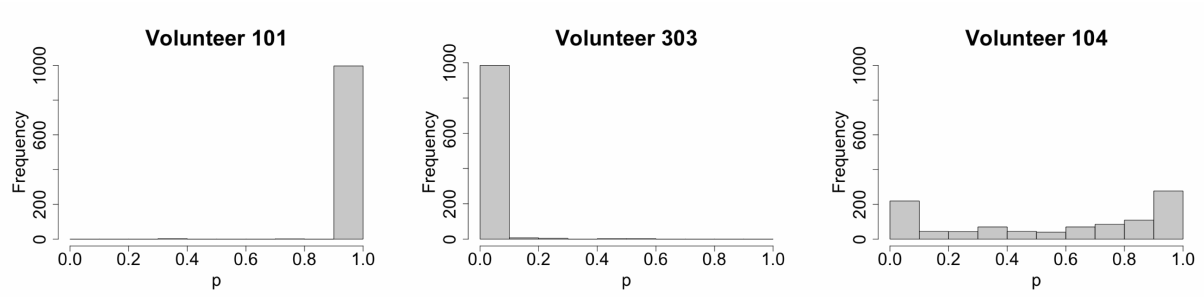
Figure 5. Distribution of the extinction probability at the end of simulation time for volunteer 101, 104 and 303.